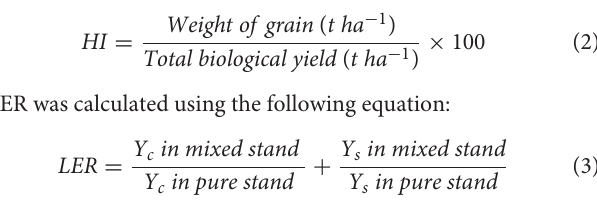
TABLE 1 | Treatment combinations used in the study.